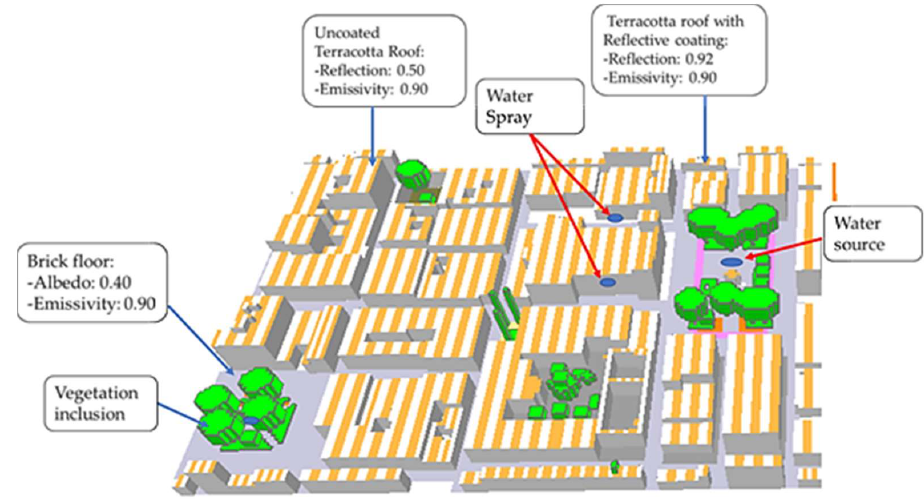
Figure 9. Schematic of case 2 developed in Envi-met.